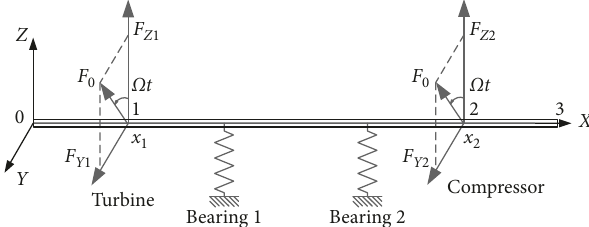
Figure 7: Applying position for unbalanced exciting